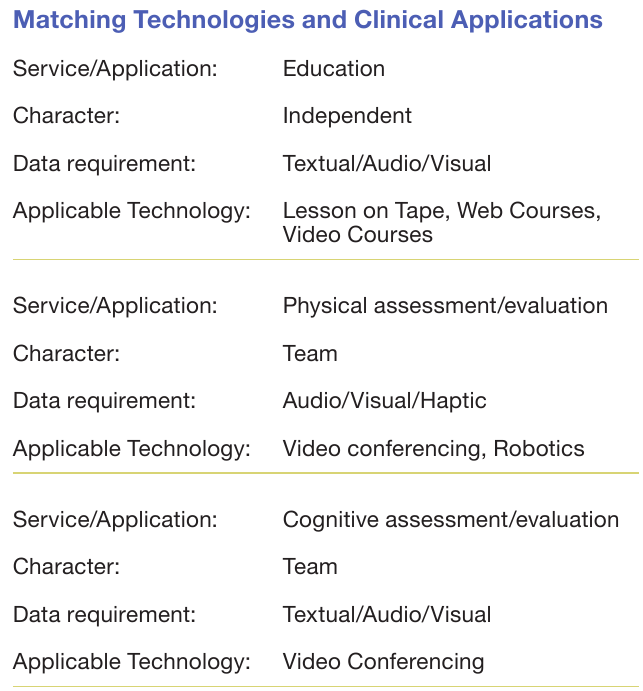
Table 4: Matching technologies and clinical